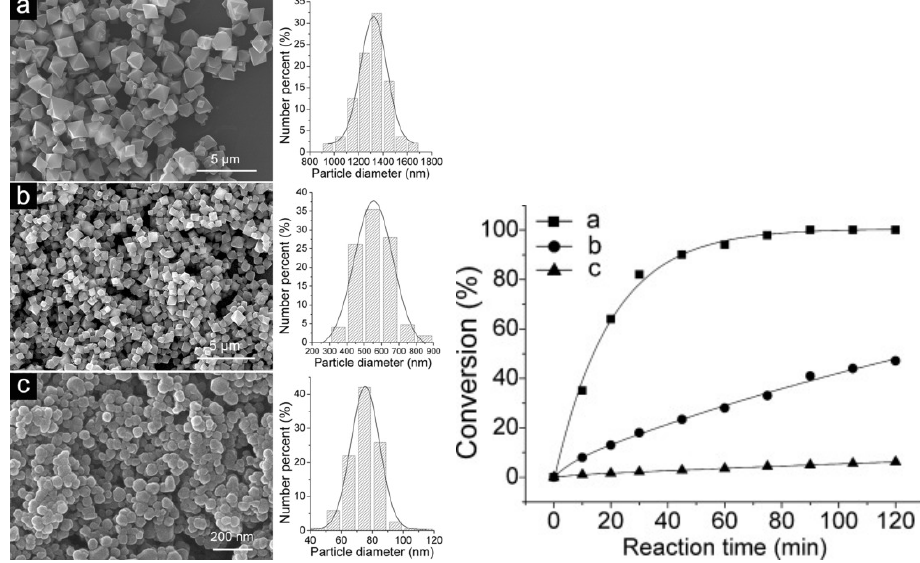
Figure 3. (a) Field emission SEM of Northeast Normal University (NENU)-9N with ( a ) copper nitrate as the metal source at pH 2.5, ( b ) copper acetate as the metal source at pH 2.5, and c) copper acetate as the metal source at pH 4.0. The percentage of DBT-to-DBTO 2 conversion versus reaction time by using a) NENU-9N (average diameter = 550 nm), ( b ) NENU-9 (average diameter = 300 mm), and ( c ) POVM (average diameter = 300 mm) as catalysts. Reaction conditions: catalyst (0.01 mmol), DBT (147 mg, 0.8 mmol), and isobutyraldehyde (0.72 mL, 8 mmol) in decalin (50 mL) at 80 °C. Reprinted with permission from [75]. Copyright (2013), John Wiley and Sons.